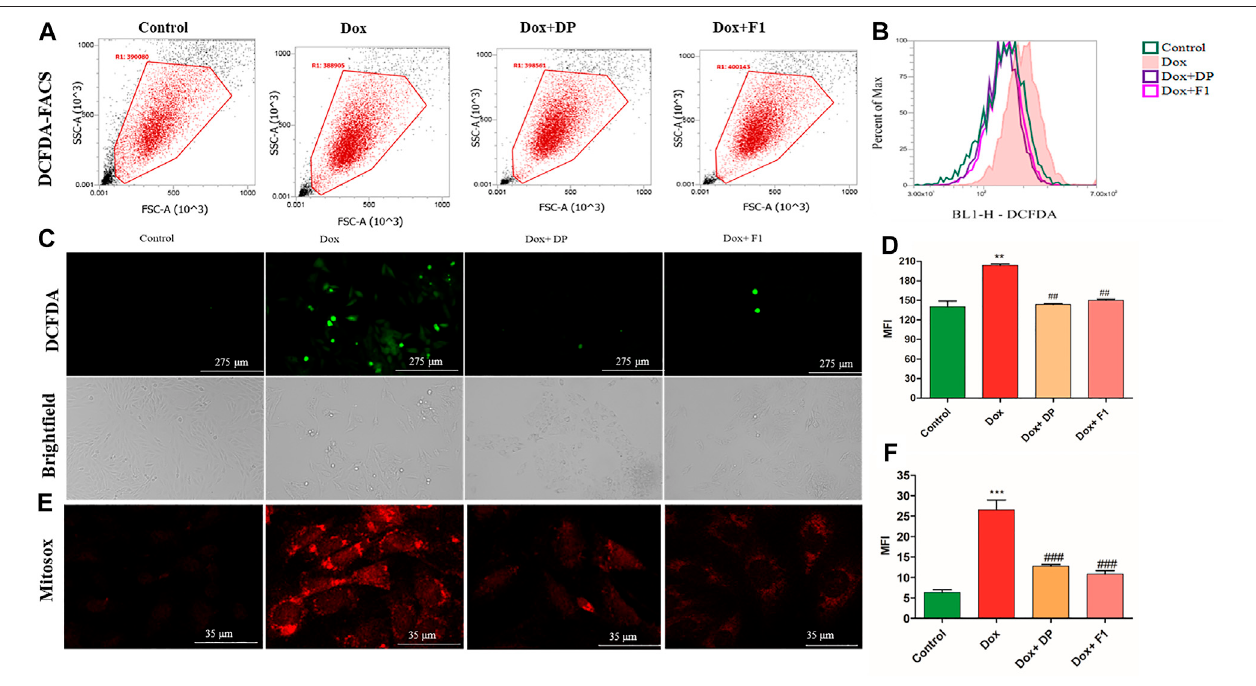
FIGURE 3 | In-vitro evaluation of the cardioprotective effect of the DP and fraction F1. (A) Quantitative analysis of ROS by DCFDA using fl ow cytometer. (B) Histogram overlay of DCFDA shift (C) Representative bright fi eld and fl uorescent images of the DCFDA stained cells. (D) Mean fl uorescence intensity of DCFDA. (E) Representative superoxide radical generation using Mitosox staining. (F) Quantitative measurement of mean fl uorescence intensity (MFI) of Mitosox red. The data were analyzedbyOneWay ANOVA using GraphPad Prism. *** p < 0.001,and ** p < 0.01representsControlvs Dox control. ## p < 0.01and ### p < 0.001 represents Dox control vs Treatment groups ( n (cid:2)